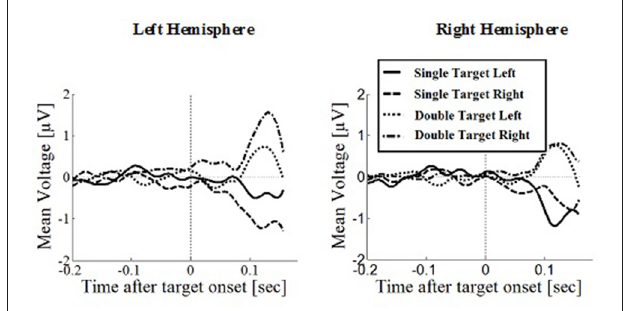
FIGURE 5 | Wave plot of the occipital response for saccade conditions in the left hemisphere (left) and the right hemisphere (right) of the brain.